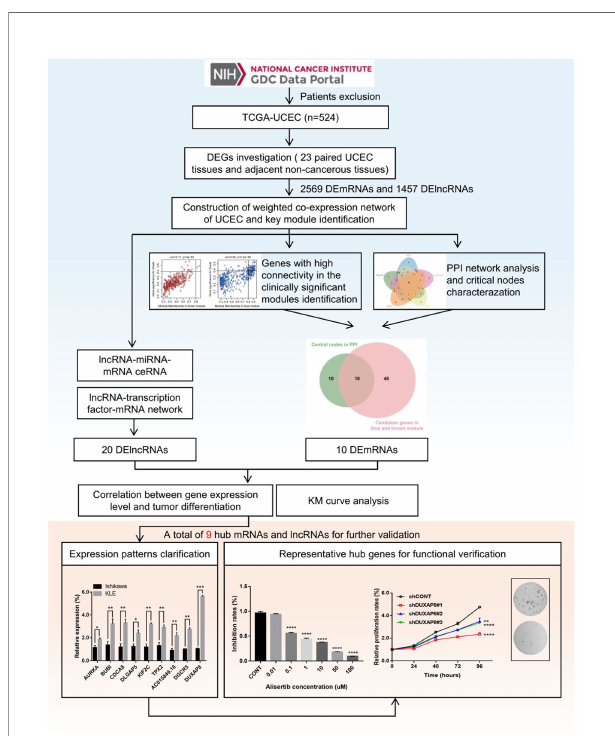
FIGURE 1 | Flowchart of the study. 548 patients with UCEC and corresponding clinical information were obtained from the TCGA database. According to the exclusion criteria, a total of 24 cases were excluded, and 524 UCEC patients were selected in this study. DEGs (including mRNAs and lncRNAs) were screened based on the gene expression data of 23 paired UCEC tissues and adjacent non-tumor endometrial tissues. Further, WGCNA algorithm was applied to construct the co-expression network of DEGs. Combined with PPI network analysis, highly correlated gene modules and key genes that were mostly associated with the clinical traits of UCEC were identi fi ed. Besides, the lncRNA-miRNA-mRNA and lncRNA-TF-mRNA networks were constructed to investigate the molecular mechanisms of UCEC-related lncRNAs. Finally, after a range of screening, 6 mRNA strands and 3 lncRNA strands with prognostic predictive potential were identi fi ed, of which expression patterns were experimentally validated. Moreover, AURKA and DUXAP8 were selected as representative hub genes for functional veri fi